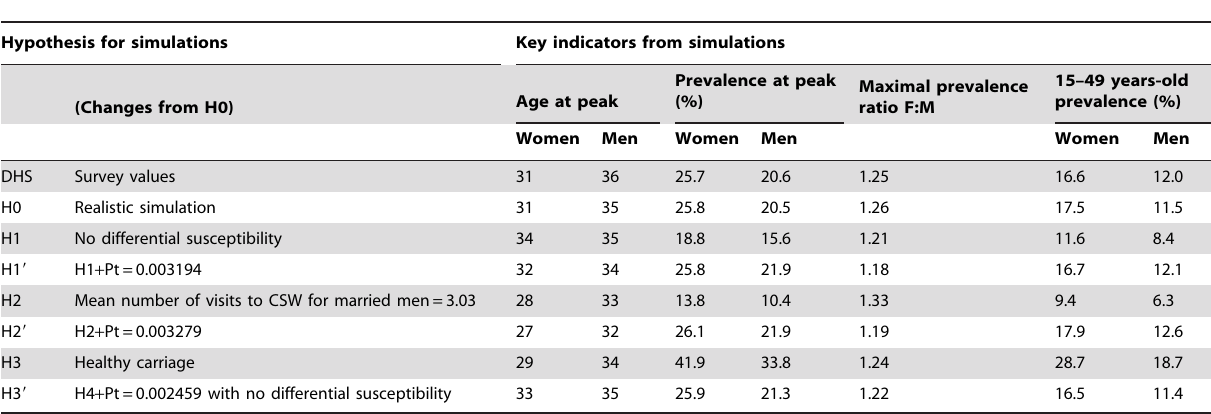
Table 3. Assumptions made to test the impact of key parameters and their results on key indicators after simulations.